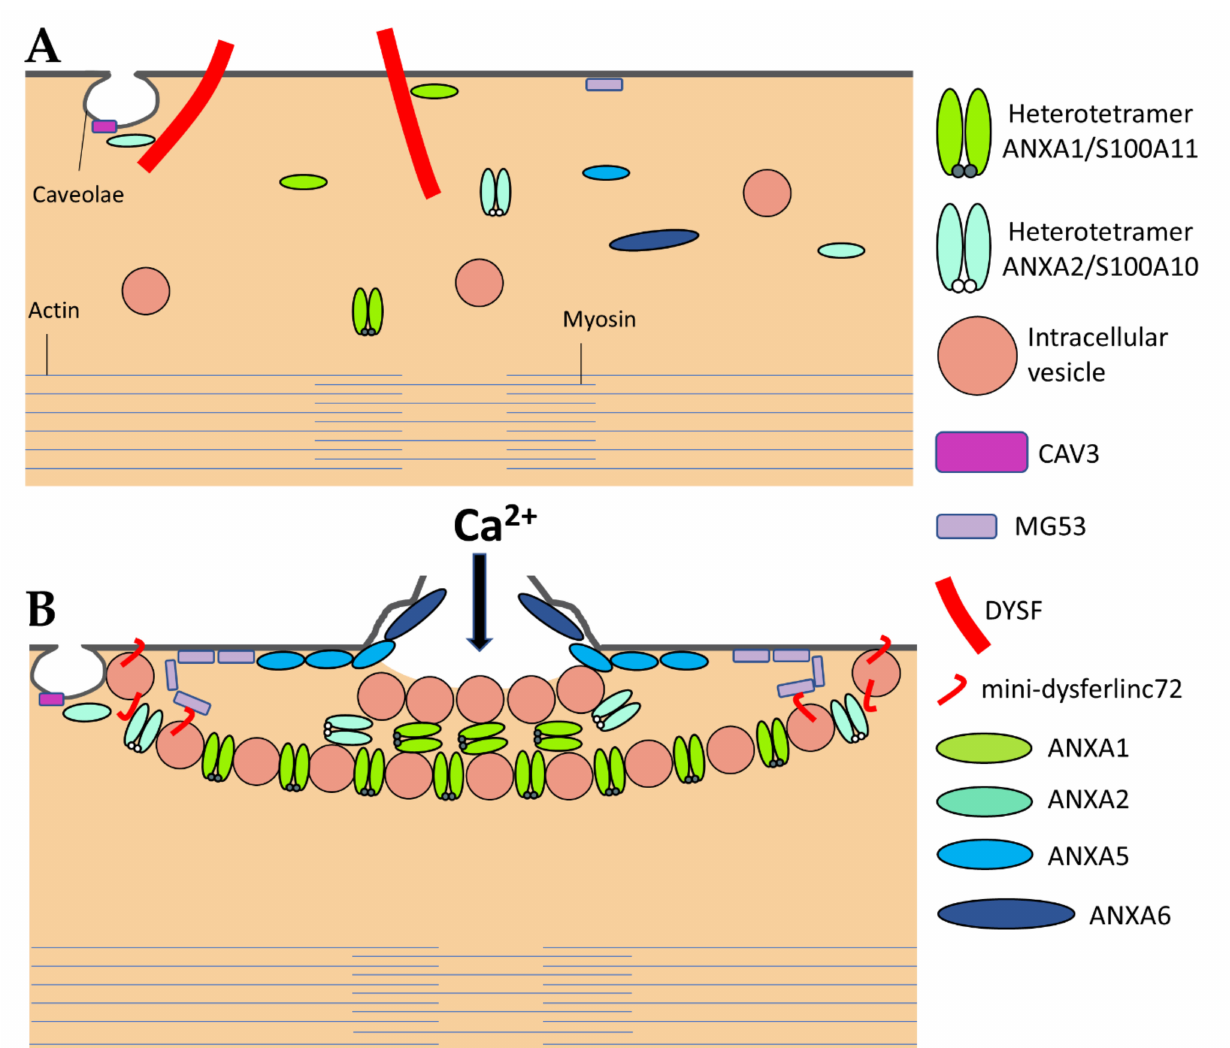
Figure 3. The sarcolemma repair machinery. ( A ) In normal, intact myofibers, full-length DYSF is localized at the sarcolemma where it interacts with ANXA1 and ANXA2. ANXA2 may also interact with CAV3. MG53 is mostly tethered to the sarcolemma. All other components of the membrane repair machinery may be soluble in the sarcoplasm. ANXA1 and A2 exist as both monomeric and heterotetrameric forms with their binding partners S100A10 (for ANXA2) and S100A11 (for ANXA1). ( B ) A disruption of the sarcolemma results in the influx of Ca 2+ and oxidized milieu into the sarcoplasm that activates (1) the recruitment of ANXA5 and MG53 to the edges of the torn membrane that form arrays, which stabilize and prevent the expansion of the rupture, (2) the formation of the “lipid patch” through interaction of ANXA1 and ANXA2 -covered vesicles, (3) generation of mini-dysferlinec72 and the recruitment of mini-dysferlinec72-covered vesicles, that ensures hanging of the patch to the damaged sarcolemma, and (4) the recruitment of ANXA6 at the disruption site that may induce folding and curvature of the sarcolemma, which promote the formation of a tight membrane structure, i.e., the repair cap subdomain. Adapted from